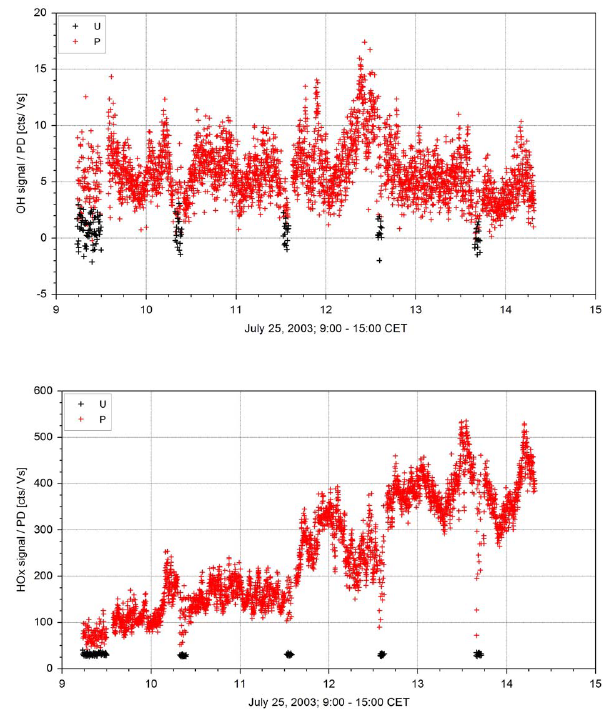
Fig. 4. On (P) and off (U) resonance signals (cts/Vs) for OH (upper panel) and HO x (lower panel) measured by LIF on 25 July 2003 at 37m height above ground.